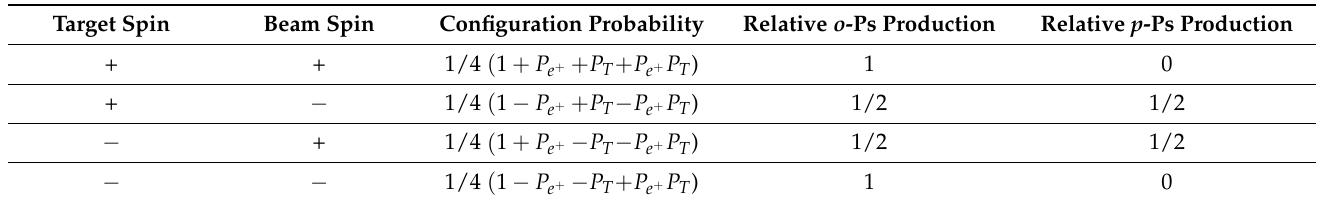
Table 1. Relative production probabilities of ortho-positronium ( o -Ps) and para-positronium ( p -Ps) for a target of electron polarization P T and a positron beam of polarization P e +